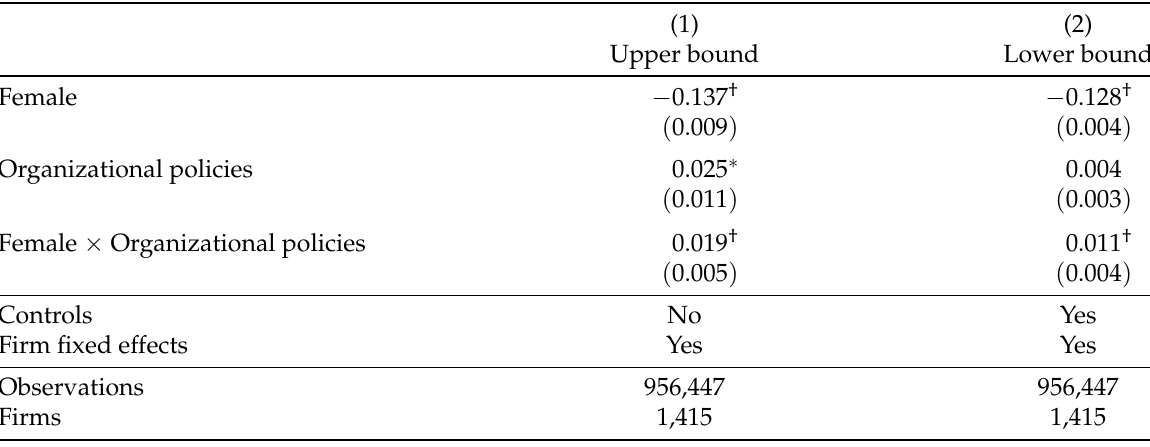
Table 4: Organizational practices and the gender wage